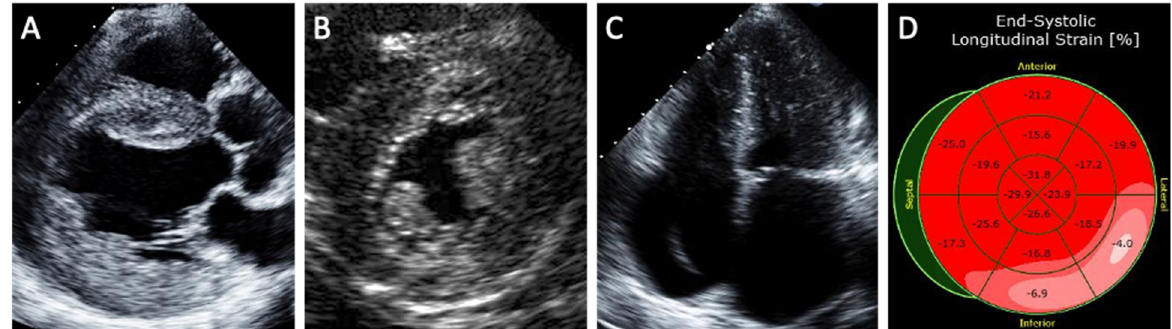
Figure 1. Structural abnormalities detected on echocardiography in patients with Fabry cardiomyopathy. ( A ) Parasternal long-axis view shows increased left ventricular wall thickness (the hallmark feature of Fabry cardiomyopathy) along with thickening of the aortic and mitral valves as well as aortic dilatation. ( B ) Parasternal short-axis view shows prominent papillary muscle and binary sign (hyperechogenic endocardial layer of glycolipid-enriched smooth muscle cells adjacent to a hypoechogenic subendocardial layer relatively devoid of glycolipids). ( C ) Severe biatrial enlargement with a device lead seen in the right-sided chambers for treatment of advanced conduction disease. ( D ) Reduced longitudinal strain in the basal inferolateral segment characteristic of Fabry cardiomyopathy.